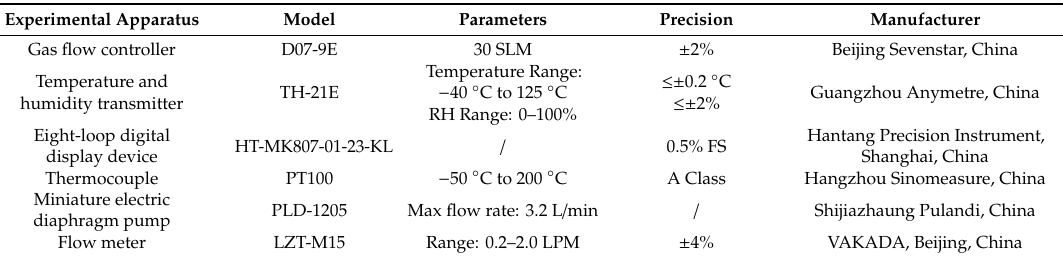
Table 3. Parameters of experimental